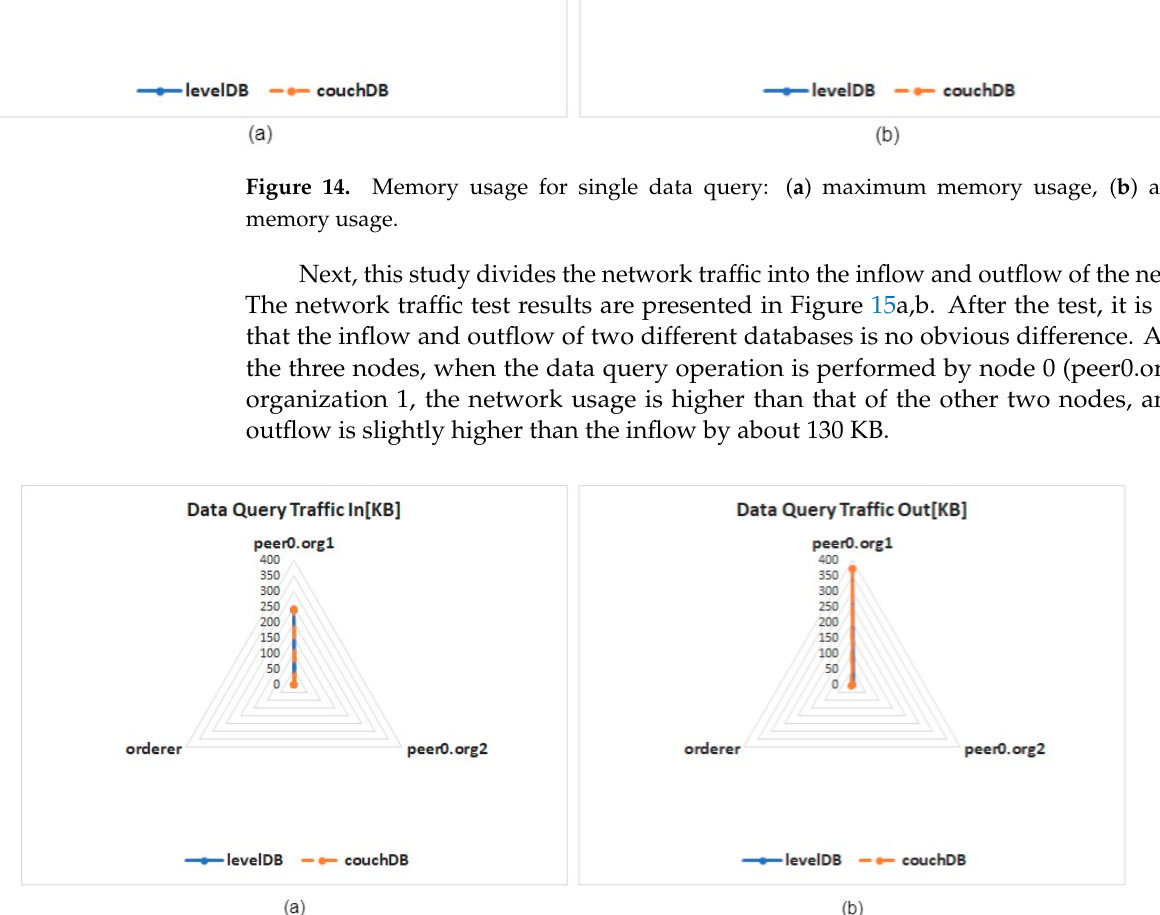
Figure 16. Latency results for single-data queries: ( a ) Maximum latency results, ( b ) Average latency results. 4.2. Security Analysis This section defines a federal Hyperledger verification framework for the DVP and analyzes the associated threats against the proposed structure. Finally, the advantages are compared with the results of other research. In the proposed framework, when a citizen travels across national borders, authenti- cation in other countries and information on the traveler’s vaccine administration is re- quired, and federal identity authentication is used to confirm the citizen’s identity. To prevent data leakage or theft, secure communication is required during communication and data exchange. Although the blockchain network is highly secure and robust [22], if there is a loophole in the smart contract during the construction of the system, the system will be in danger. Therefore, the following security analysis for the proposed architecture is discussed. Reentrancy: A reentrancy attack is a kind of network attack that is highly harmful and destructive to smart contracts. A reentrancy attack occurs when a function is called externally by another untrusted contract, untrusted contracts make recursive calls to func-